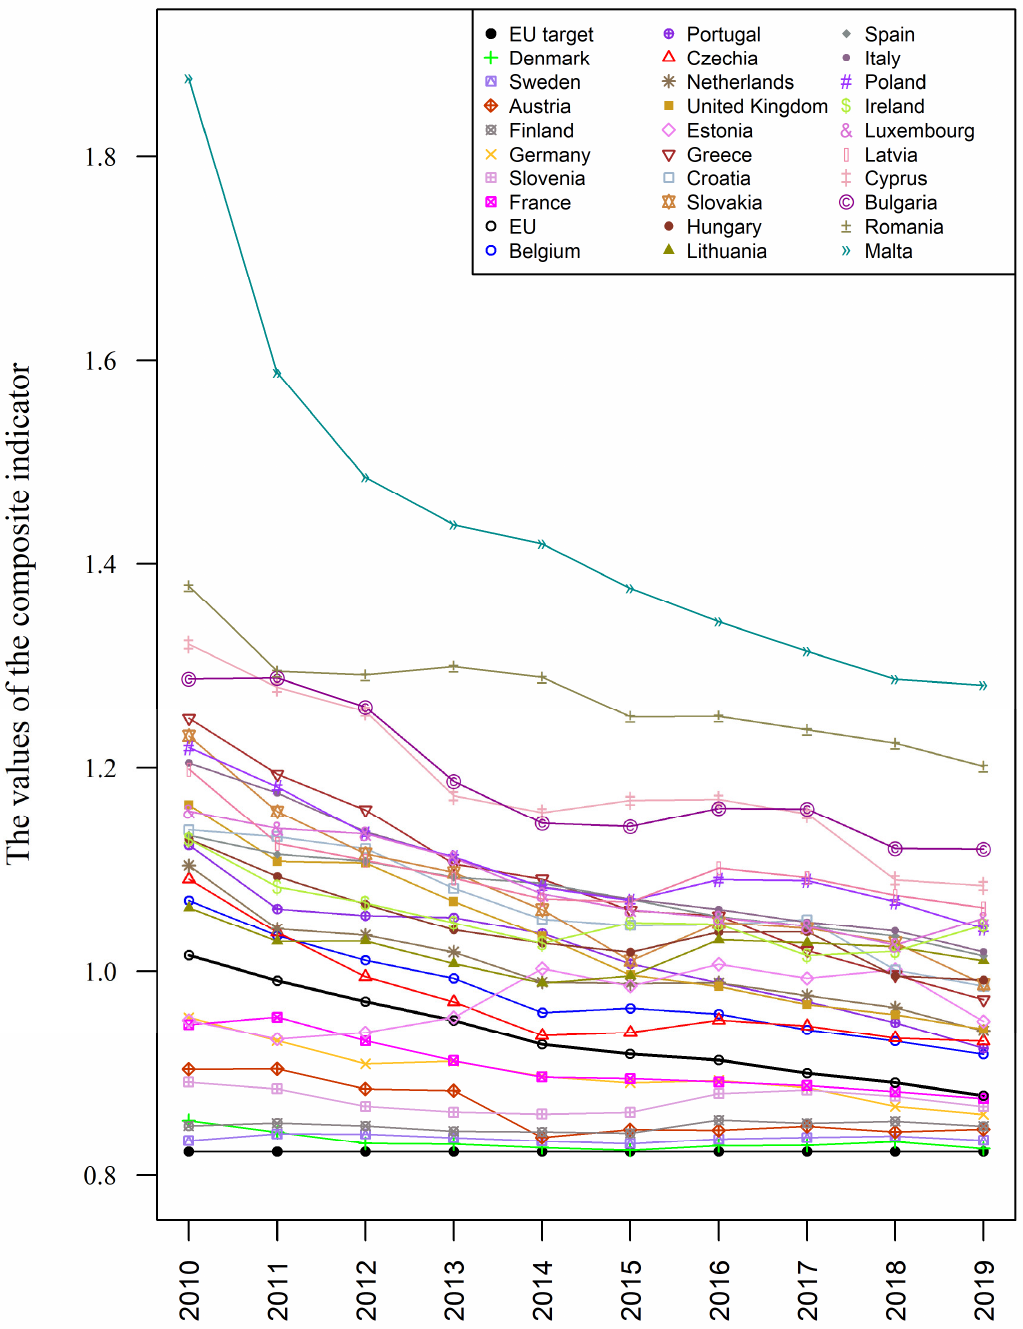
Figure 2. Graphic presentation of the changes from 2010 to 2019 in the level of the EU Strategy implementation. based on SM it composite indicator for the European Union countries. Source: authors’ compilation.